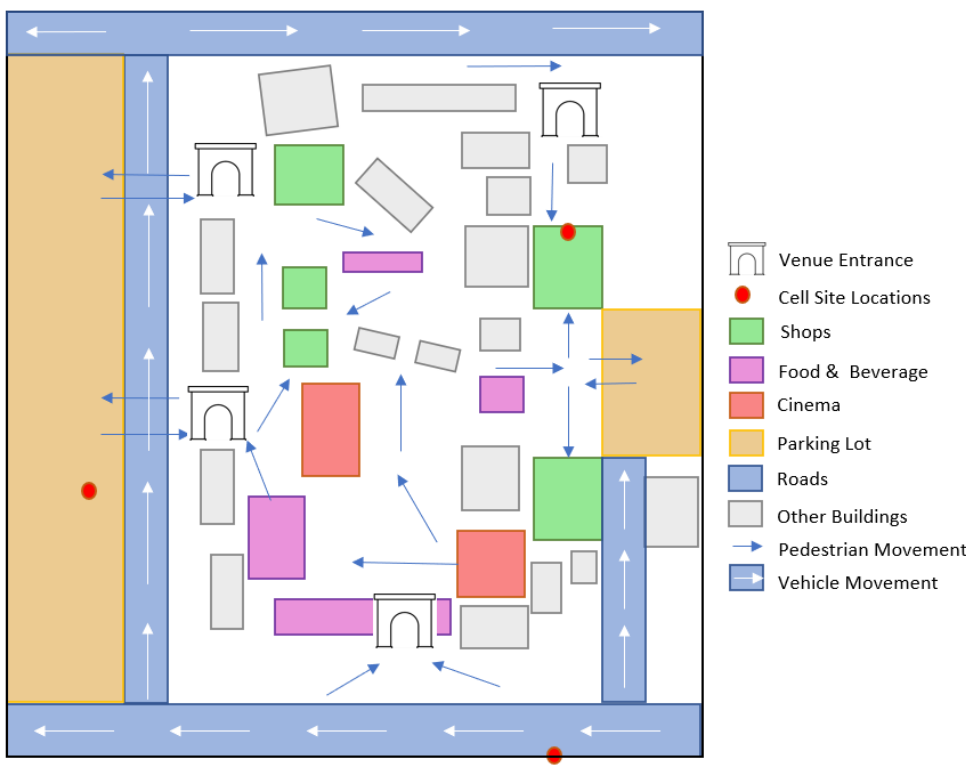
Figure 3. Each area was linked with predefined paths according to the actual topology of the underlying area for added realism. The areas of interest were split into various categories characterized by mobility information and traffic usage levels. Areas that generate notable mobile user hot-zones are recreation areas (high mobile usage and high dwell time), which are typically coffee shops, restaurants, etc. and offline areas where high density and high dwell time was observed but mobile phone usage was limited (e.g., parking lots and cinemas).